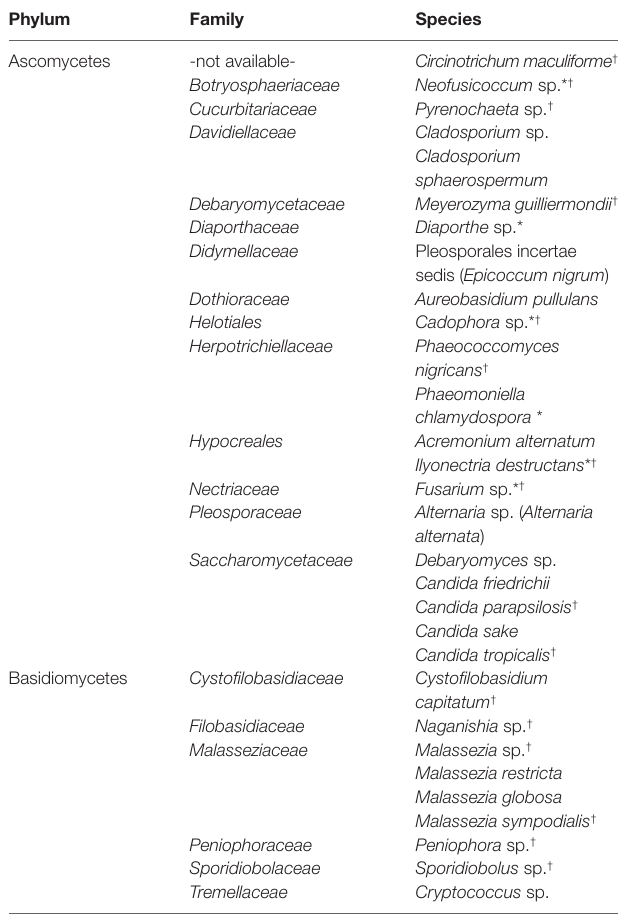
TABLE 2 | Taxonomic classification of the most abundant taxa identified to genus or species level in the wood of grapevine rooted